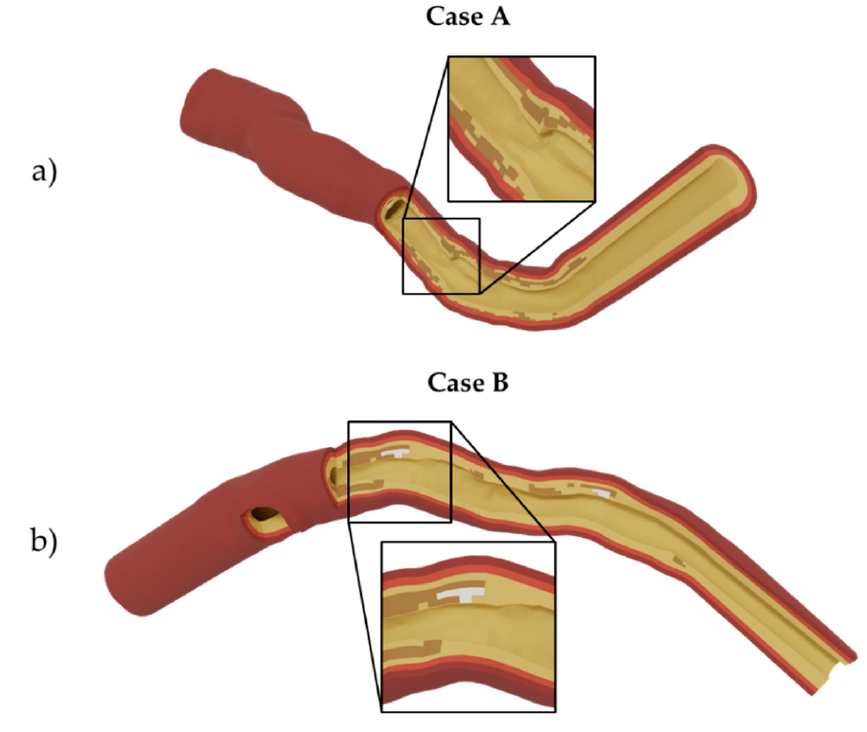
Figure 6. Sections of the 3D reconstructed geometries of the two patient-specific coronary arteries: ( a ) Case A and ( b ) Case B. The modeled components (adventitia, media, generic plaque, lipid plaque, and calcific plaque) were highlighted with different colors. For Case B bifurcation, the presence of the ostium was modeled without reconstruction of the untreated side